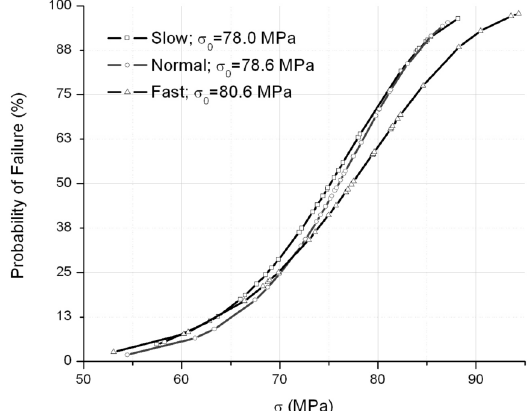
Figure 5. Probability of failure based on the flexural strength of the VM9 porcelain, according to cooling